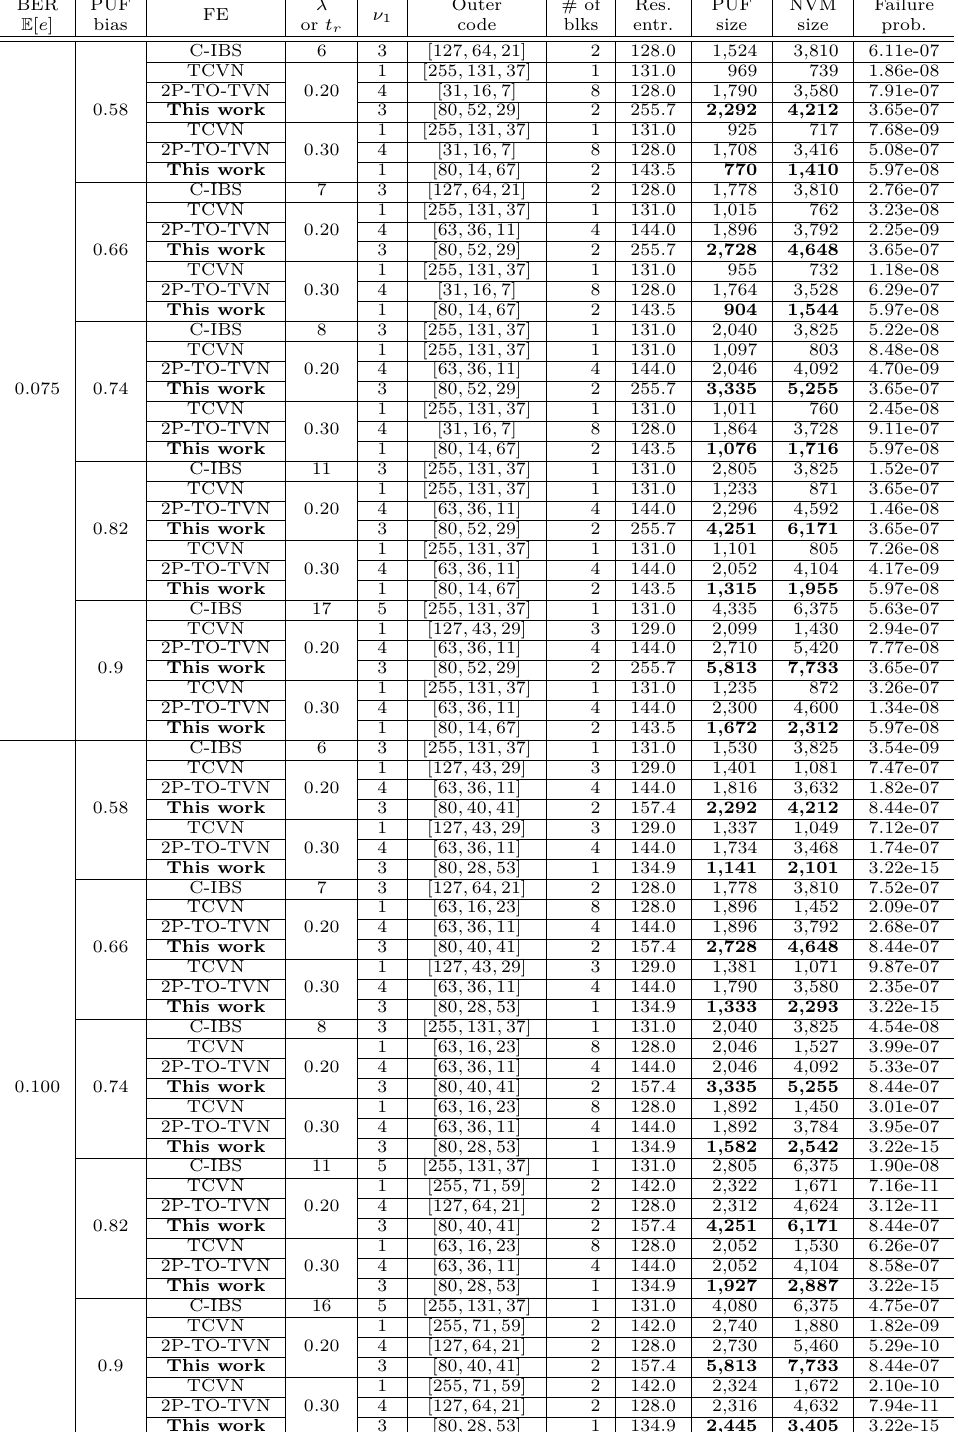
Table 8: Simulation results of 128-bit key generation using C-IBS and ternary debiasing- based FEs for averaged BER E [ e ] = 0 . 075 and 0 .